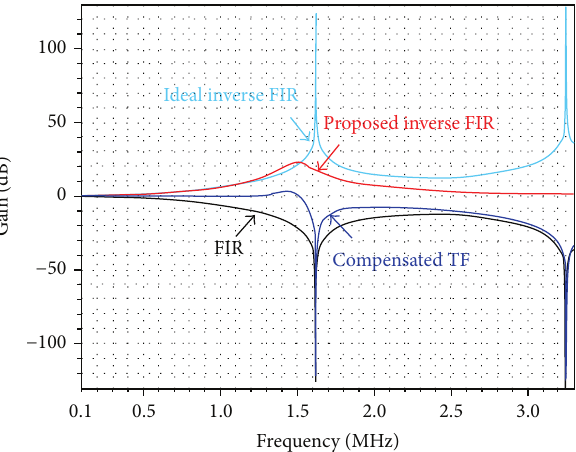
Figure 6: Simulated frequency responses of FIR-compensated filters: ideal versus proposed implementations.